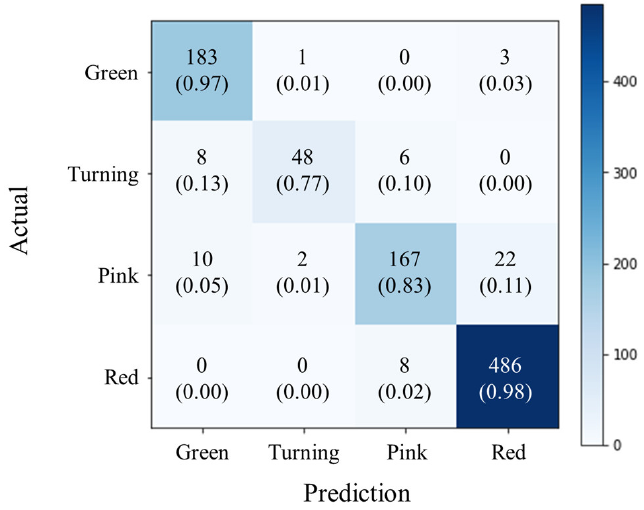
Figure 5. Confusion matrix for tomato maturity classification. Table 1. Classification performance analysis of tomato maturity estimation